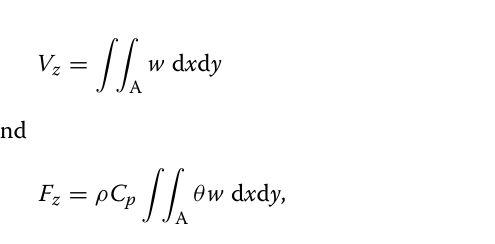
where C p is the specific heat capacity of seawater at con- stant pressure and θ is the potential temperature. ρ C p is × 10 6 J K − 1 m − 3 set to 3.99 . Time series of the vertical volume and temperature transports are shown by thick black and green lines in Fig. 14a, respectively. Both modes of transports in Region A are always positive, i.e., upward, and fluctu- ates inversely related to the PDO and Niño 3.4 indices − 0.80 − 0.79 with correlation coefficients of and , respec- tively (Table 1), being consistent with the EOF analysis in Sect. 3.2. In addition, the transport is relatively low (high) due to frequent occurrences of El Niño (La Niña)